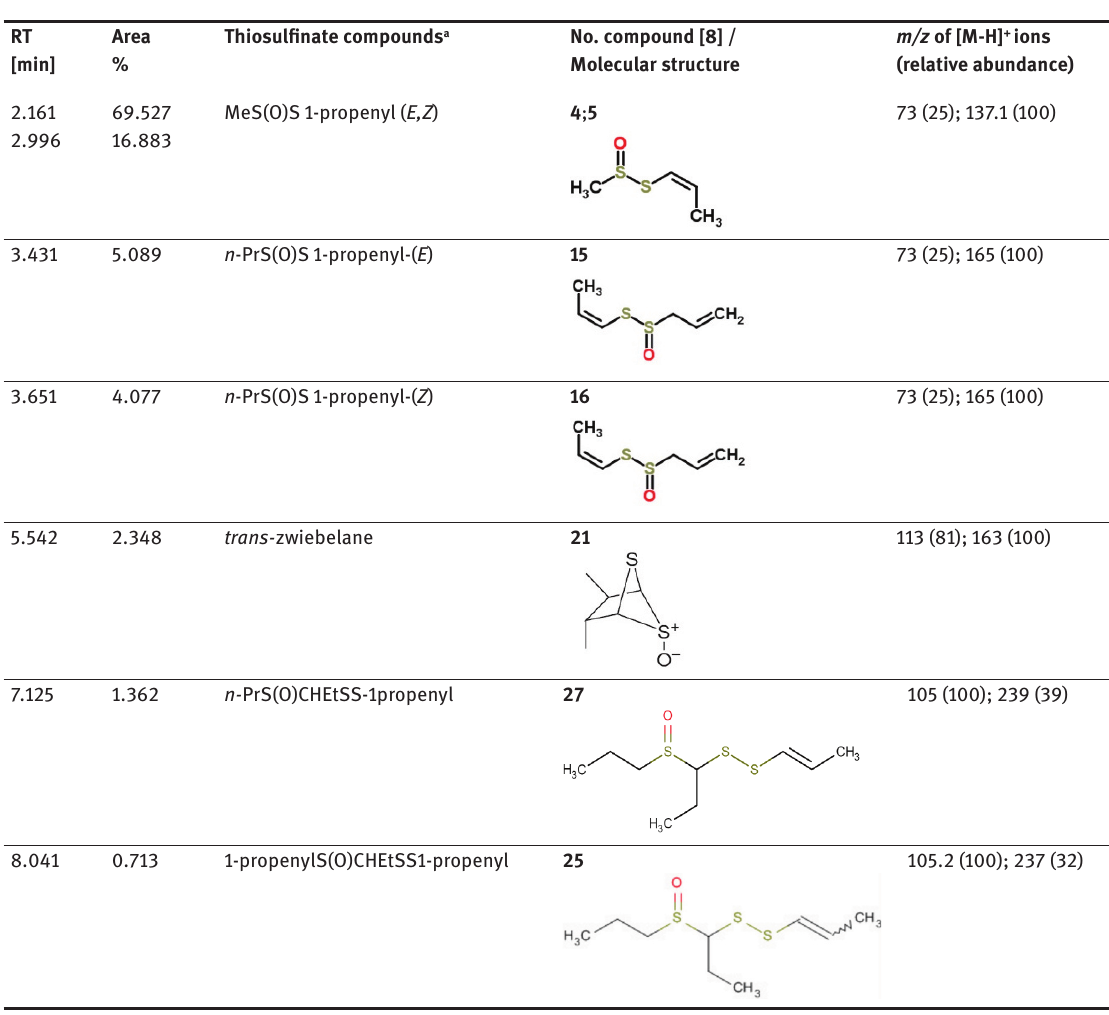
Method of discs soaked with liquid extract of Allium cepa L Method of wells in the culture medium filled with liquid extract of Allium cepa L. Method of wells in the culture medium filled with lyophilized formulation based on onion extract